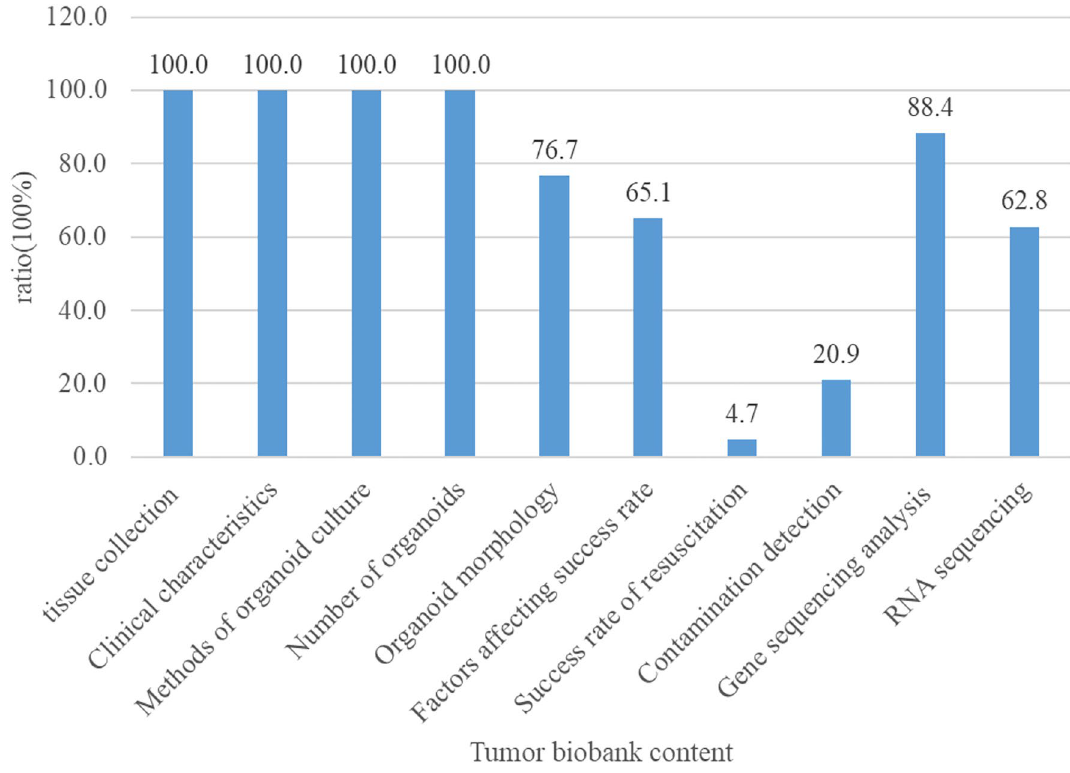
Figure 8. Common contents of PDTO